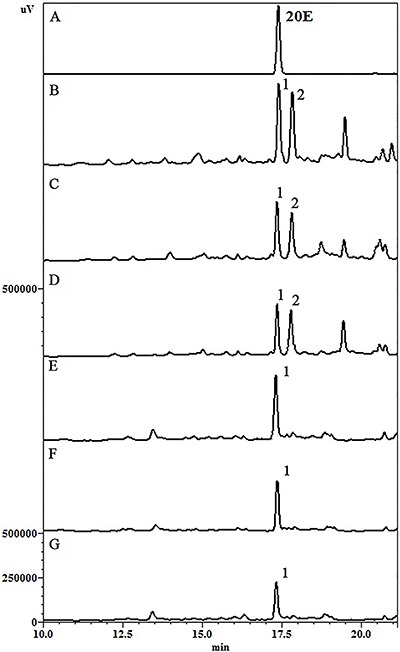
Comparative chromatogram of S. tuberculata extracts, using 40% ethanol for leaves and 70% ethanol for roots. A, reference substance of 100 µg/mL 20-hydroxyecdysone (20E). B, C, and D, leaf hydroethanolic extract obtained by percolation, reflux and maceration, respectively. E, F, and G, root hydroethanolic extract obtained by percolation, reflux and maceration, respectively. Peak 1: 20E, Peak 2: Kaempferol derivative, acquired at 250 nm.